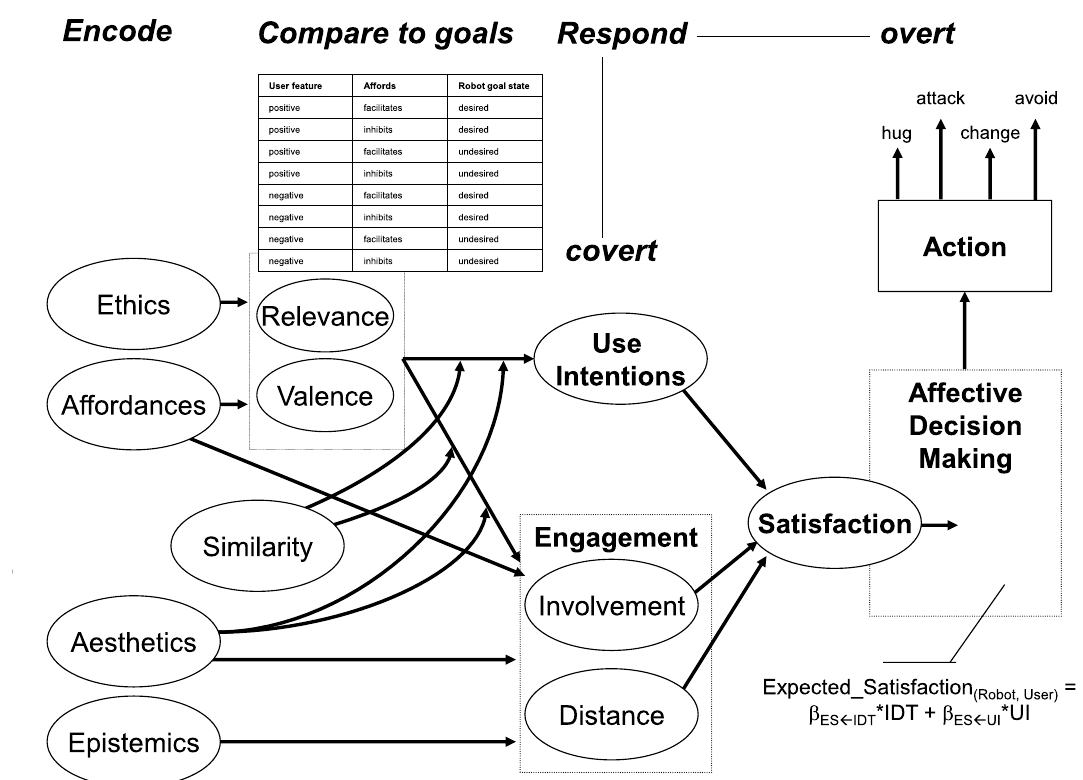
Figure 1. Dependencies in Silicon Coppélia 32 . Curved arrows indicate interaction effects. IDT involvement– distance trade-off, UI use